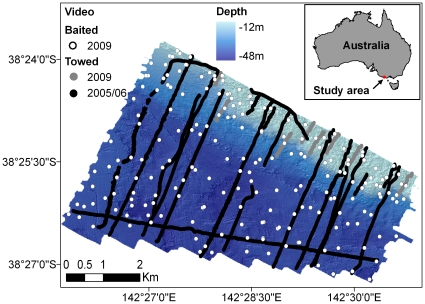
Study area.The location of the Warrnambool study area off the south-eastern coast of Australia. Shading indicates water depth. Black lines indicate towed video transects. White dots indicate baited video deployments. Red line delineates the southern extent of the Hopkins Bank.